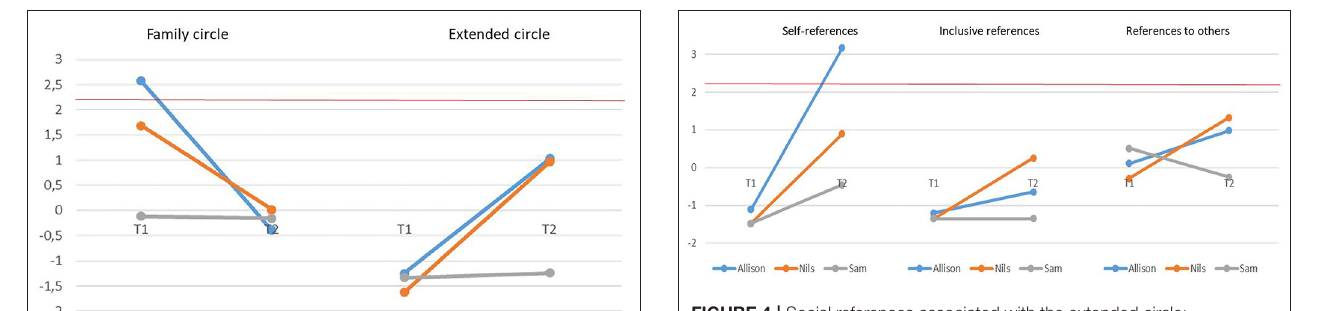
but an increase in references concerning the extended circle for both Allison ( z = − 2.27, p = 0.05) and Nils ( z = − 2.59, p = 0.05). There were significant decreases in references to others in the family circle for both Allison ( z = 3.51, p = 0.01) and Nils ( z = 3.45, p = 0.01). We observed more moderate decreases in self-references ( z = 2.03) and inclusive references ( z = 2.01)